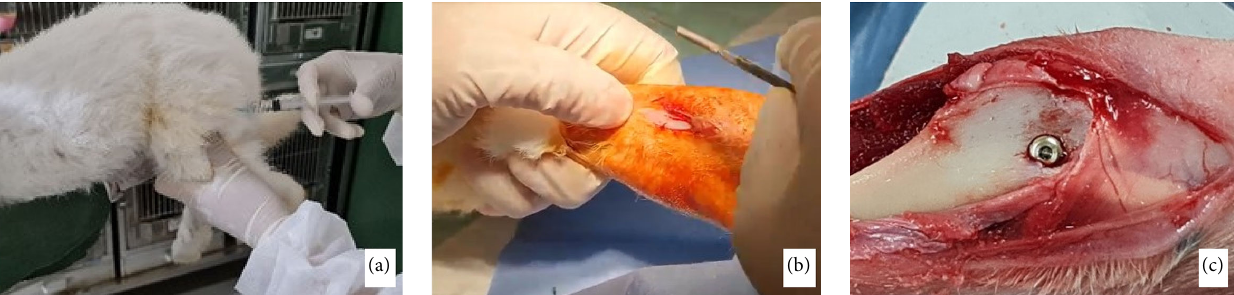
F IGURE 1: The installation of implants in the tibia of rabbits: (a) the rabbit was anesthetized via intramuscular injection; (b) incision on the superior proximal tibia; (c) implant installation.